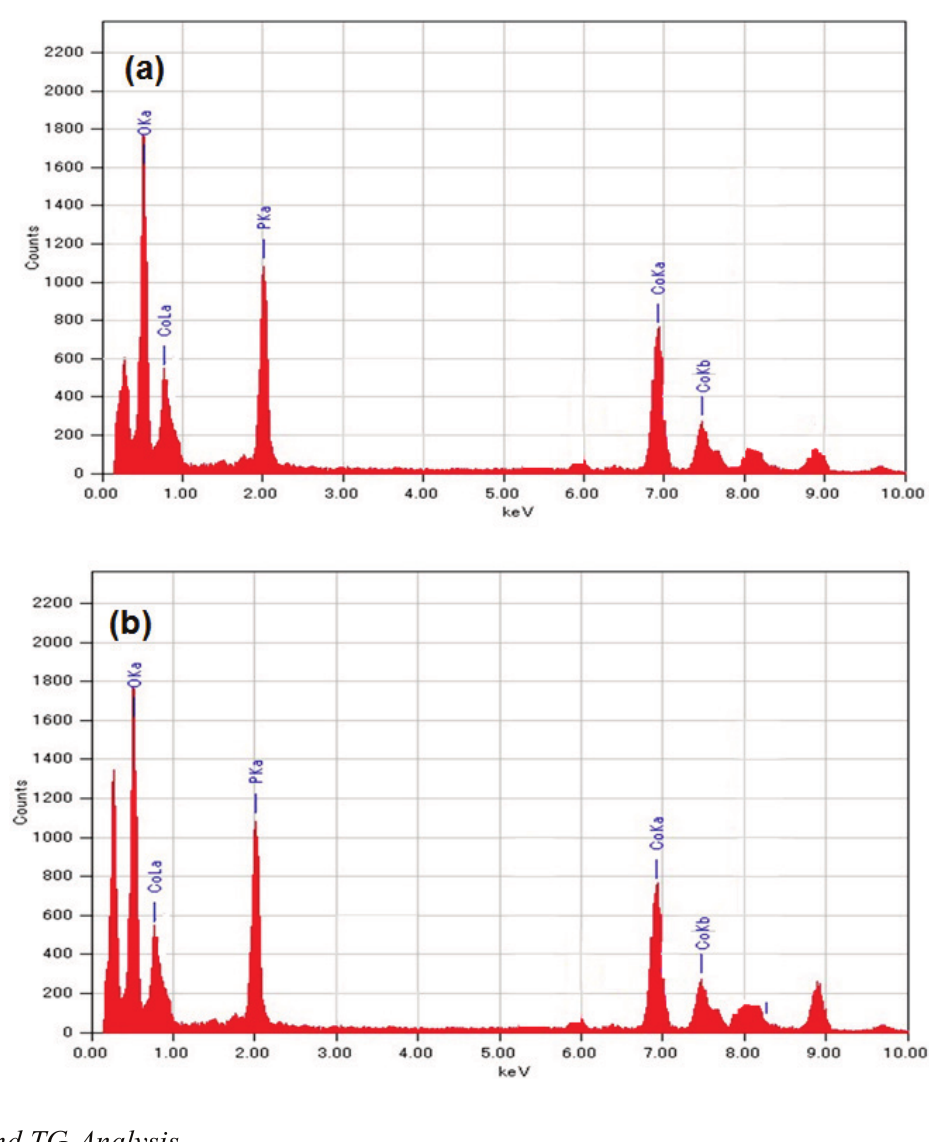
nanoparticles synthesized using ( a ) Co(NO 4